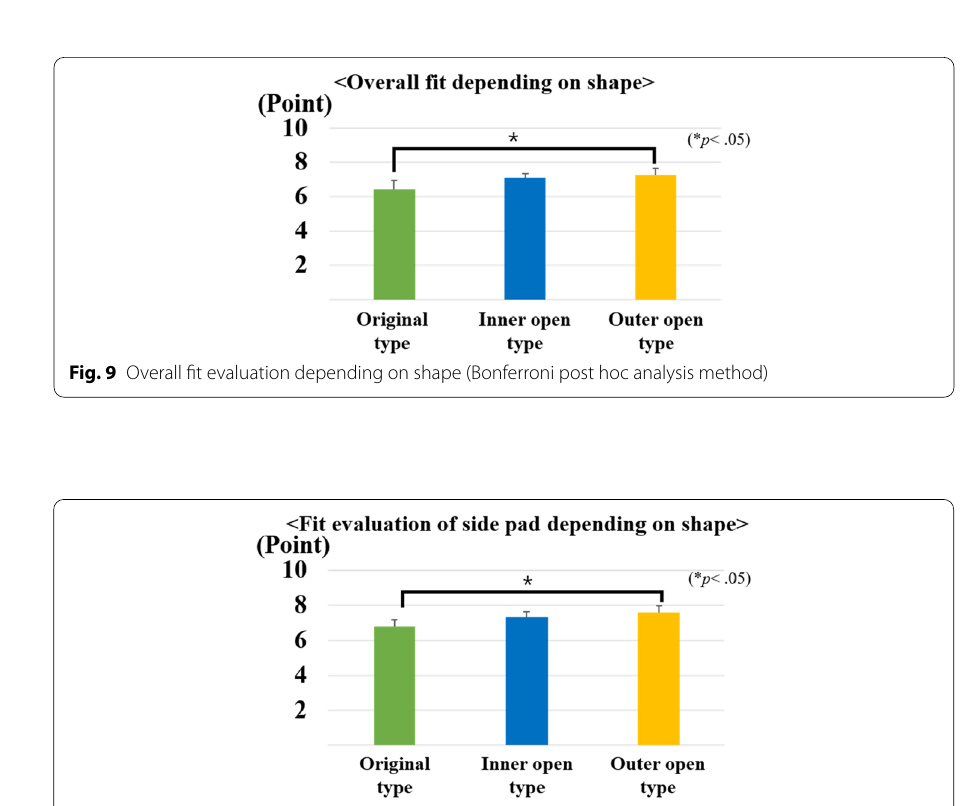
Fig. 10 Side-fit evaluation depending on pad shape (Bonferroni post hoc analysis